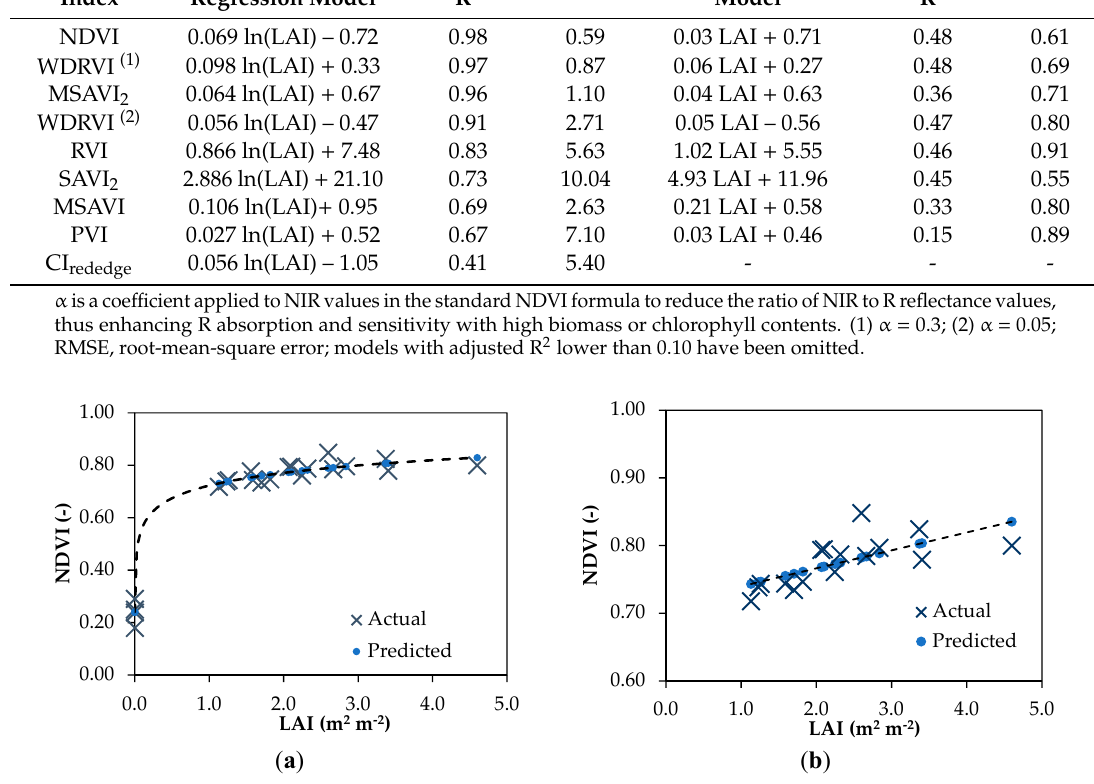
Table 2. Logarithmic and linear (with no-leaf values excluded) regression functions and their corresponding adjusted determination coefficient (R 2 ) and root-mean-square error (RMSE) of leaf area index (LAI) prediction as a function of each vegetation index. Sampling areas with no hail netting. Vegetation Index Logarithmic Regression Model